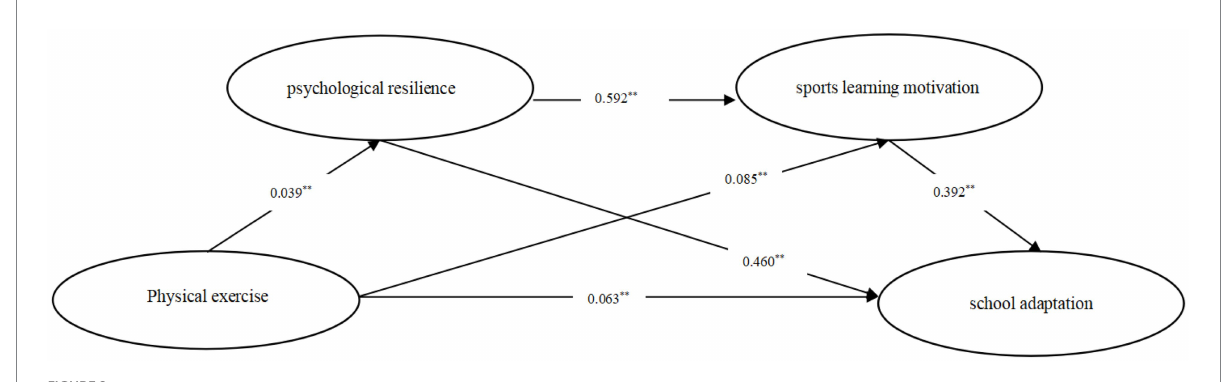
FIGURE 2 Chain mediation model of physical exercise and school adaptation. ** p <